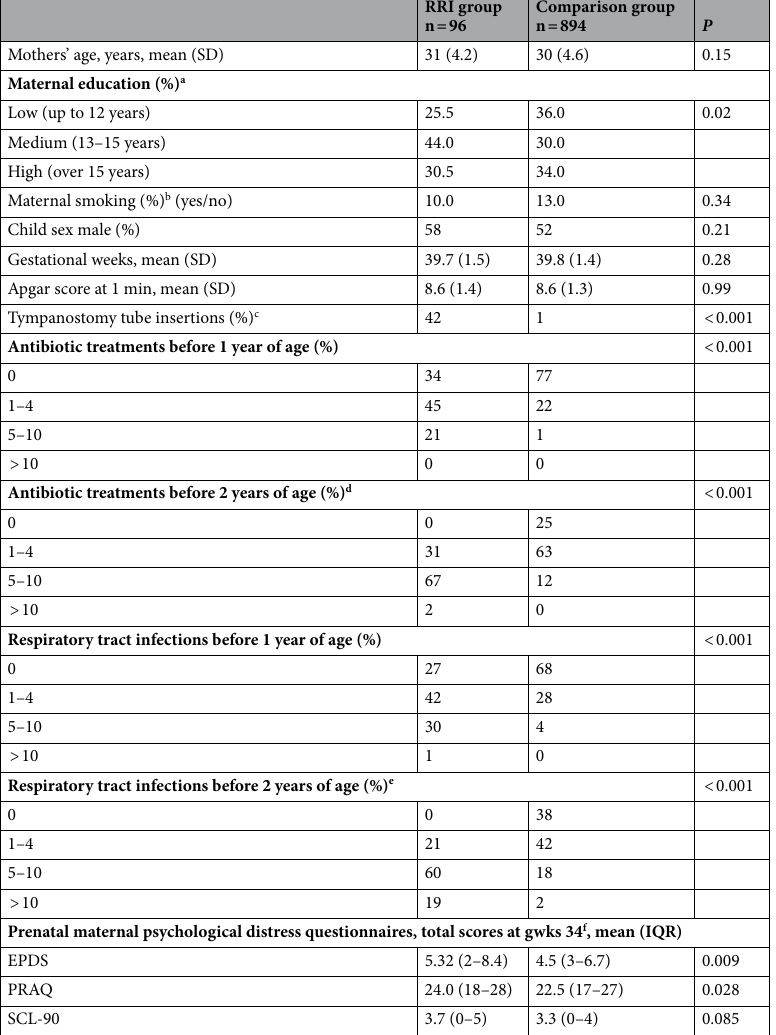
Table 1. Study population characteristics in children with recurrent respiratory tract infections (RRIs) and the comparison group. EPDS the Edinburgh Postnatal Depression Scale, gwks gestational weeks, PRAQ-R2 the Pregnancy-Related Anxiety Questionnaire–Revised2, SCL-90 the Symptom Checklist 90, anxiety subscale. P values are based on χ 2 for categorical and t-test and Mann–Whitney U test for continuous variables indicating the group comparisons. Values are presented as numbers (percentages), means (standard deviation, SD) or medians (interquartile range, IQR). a RRI-group n = 94, comparison group n = 851. b RRI-group n = 93, comparison group n = 894. c RRI-group n = 67, comparison group = 262. d RRI-group n = 49, comparison group n = 176. e RRI-group n = 48, comparison group n = 94. f RRI-group n = 93, comparison group n =